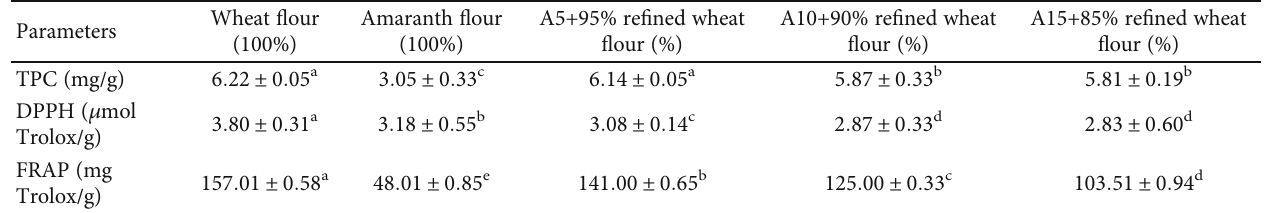
Values are expressed as means of triplicate samples ± standarddeviation ( n = 3 ). Values with the same superscripts in a column are statistically similar while values with di ff erent superscripts are signi fi cantly di ff erent ( p ≤ 0 : 05